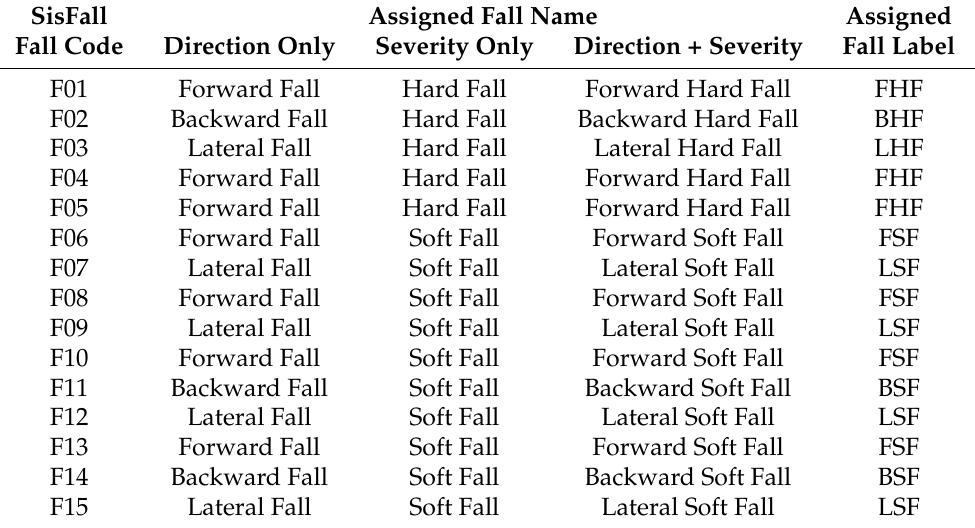
Table 2. Labeling used for Falls in the SisFall